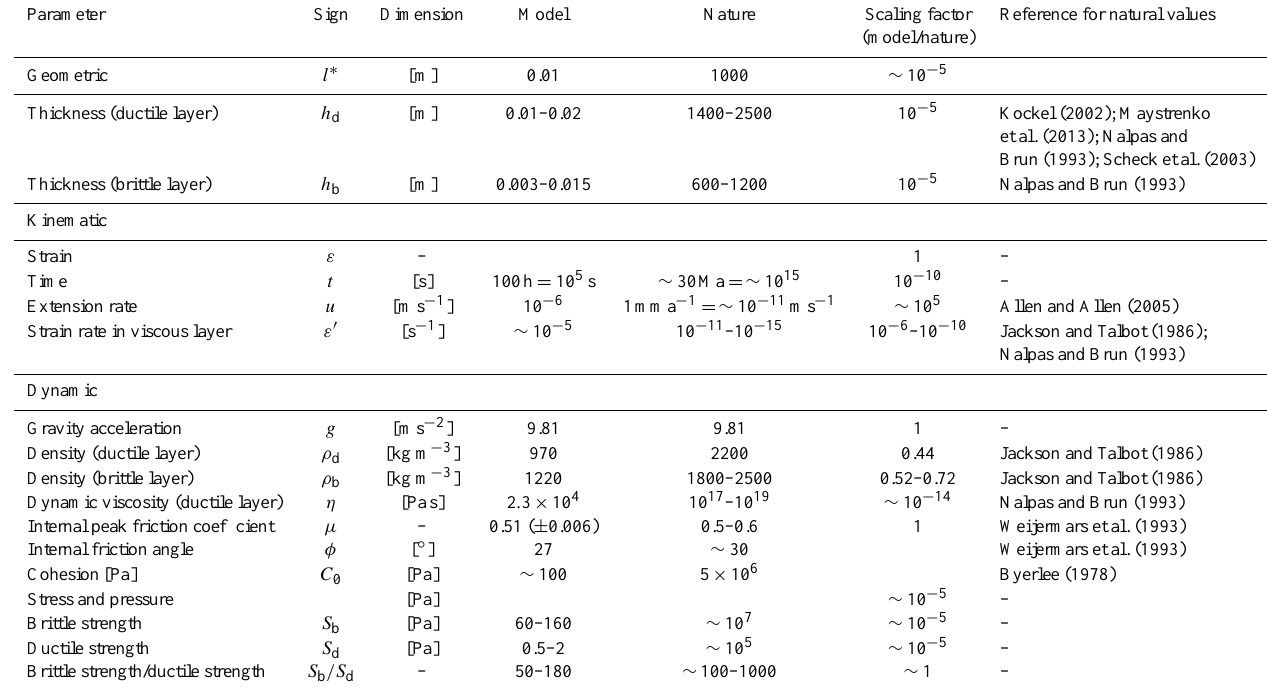
Table 1. Scaling parameters. Material properties (density, viscosity, friction and cohesion) are stated for analogue materials used in this experimental study (Appendix